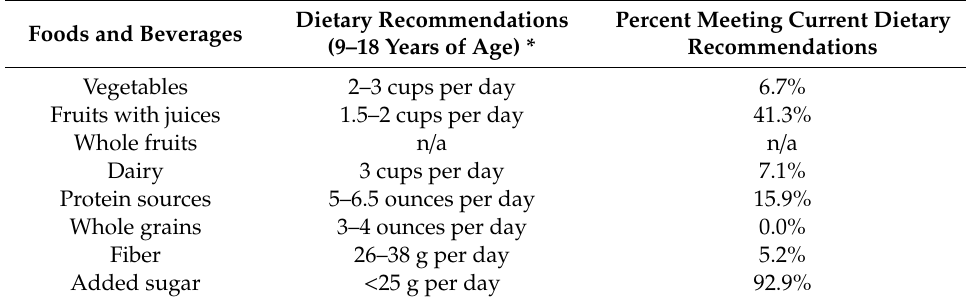
Table 2. Child-reported dietary